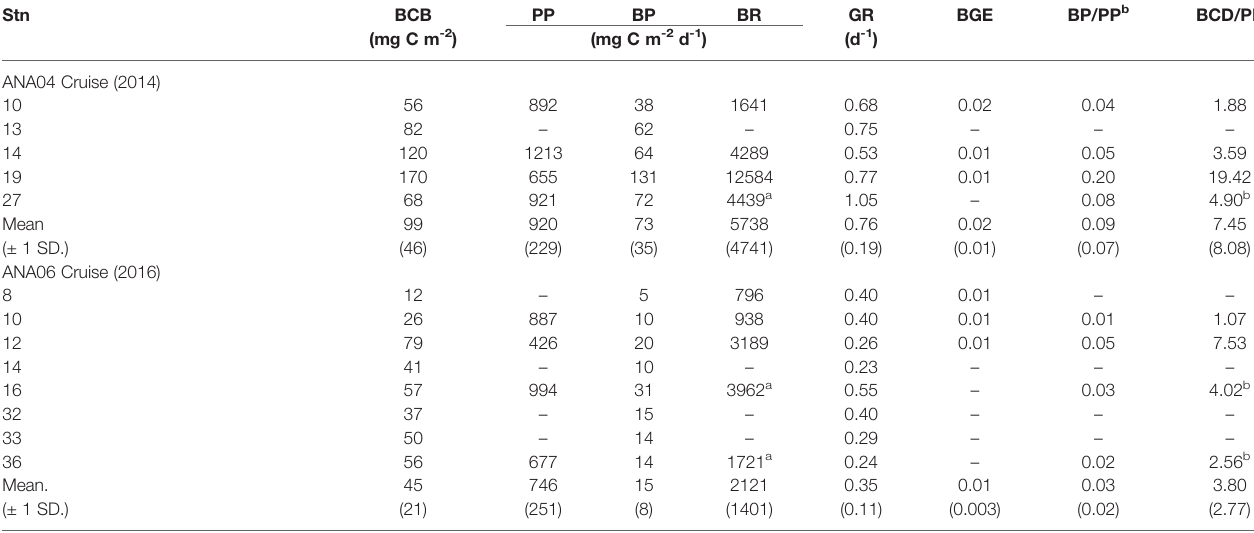
TABLE 2 | Depth-integrated (down to mixed layer depth) bacterial carbon biomass (BCB), bacterial production (BP), primary production (PP), bacterial production (BP), bacterial respiration (BR), bacterial growth rates (GR), the ratio of bacterial production (BP) to primary production (PP) and the ratio of bacterial carbon demand (BCD) to PP. Stn BCB